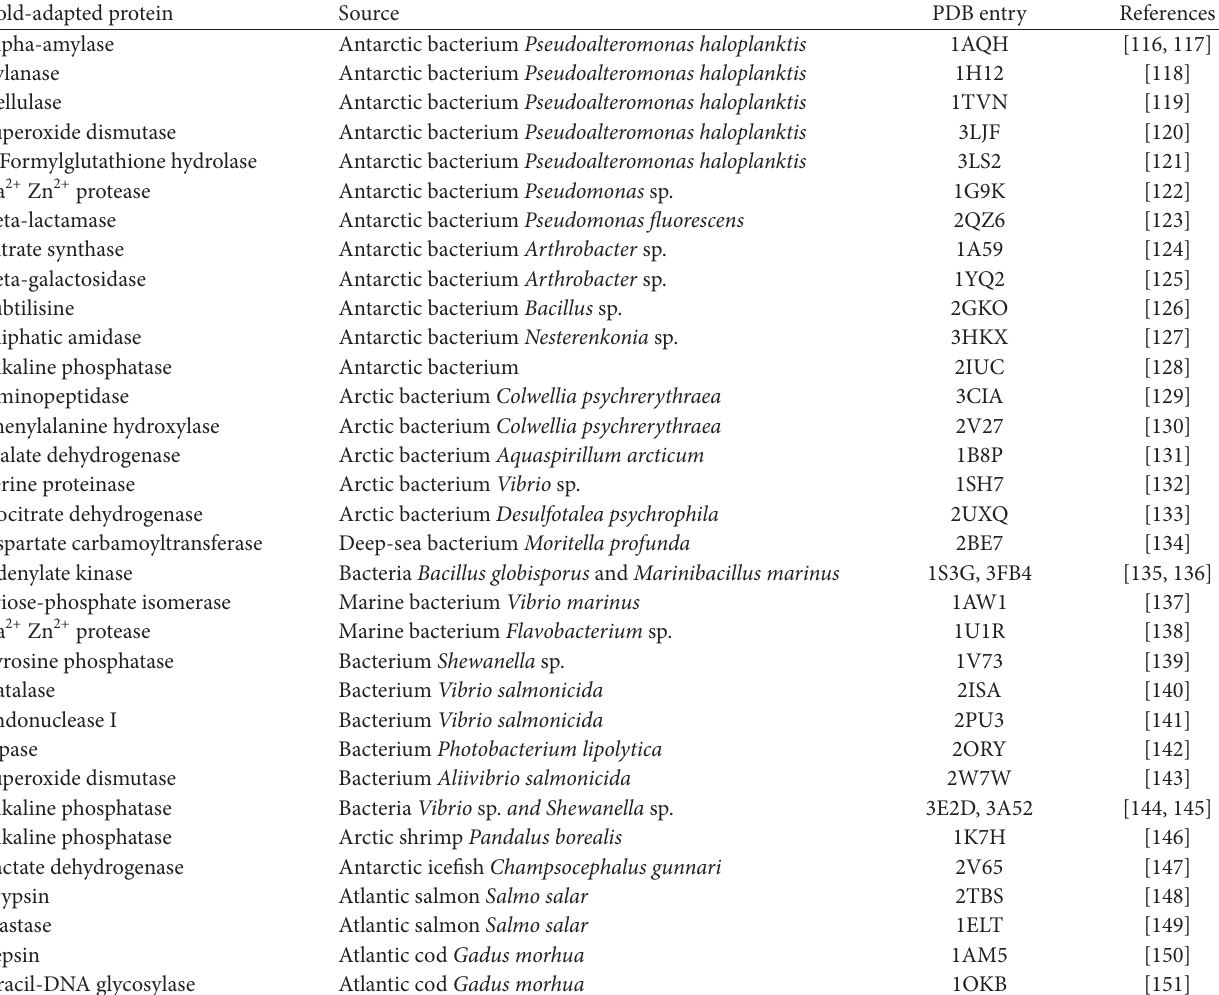
T 1: Representative psychrophilic enzymes of known crystal